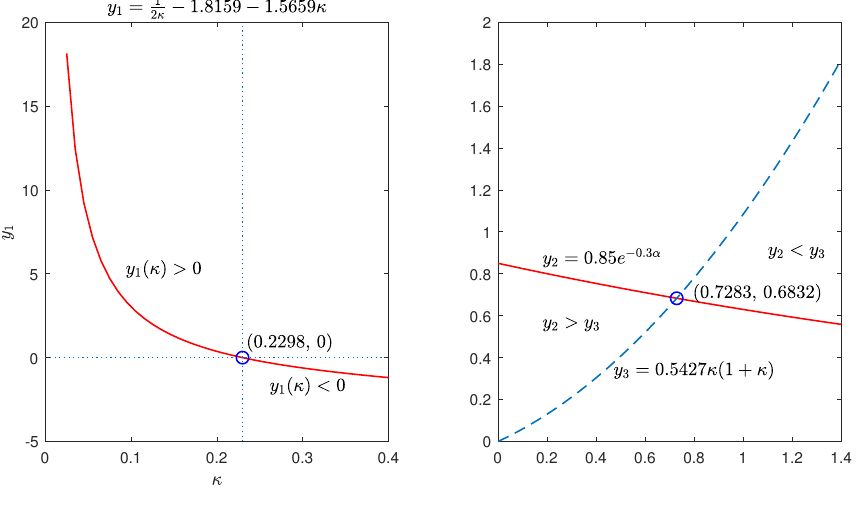
Figure 6. The curves of y 1 , y 2 and y 3